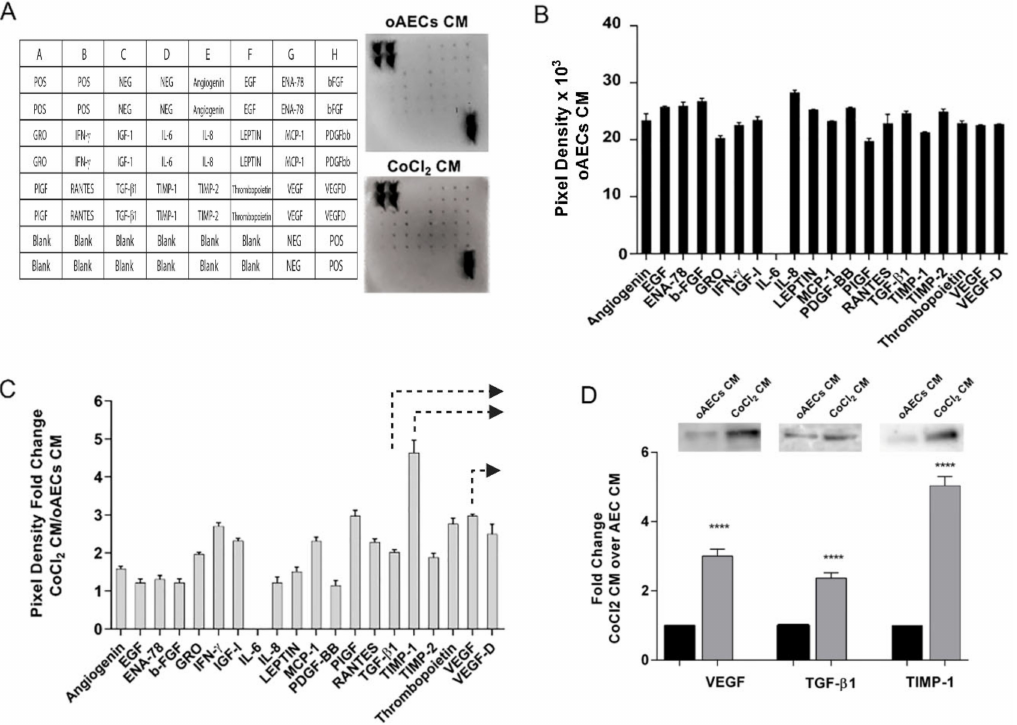
Figure 6. Angiogenic factors profile expression. ( A ) The layout of the array and representative images of chemokines detection. ( B ) Quantification by densitometric analysis of antibodies array of untreated oAECs CM, collected after 24 h after medium change. ( C ) Angiogenic proteins profile expression of CoCl 2 CM. Data are expressed as fold changes versus untreated oAECs CM values. Arrows indicate the angiogenic factors further analysed in WB. ( D ) Representative WB images of VEGF, TGF- β 1, and TIMP-1 protein content in untreated oAECs CM and CoCl 2 CM, collected after 24 h after medium change. Densitometric values are expressed as fold changes versus untreated oAECs CM values. Values statistically different for **** p < 0.0001 vs. oAECs